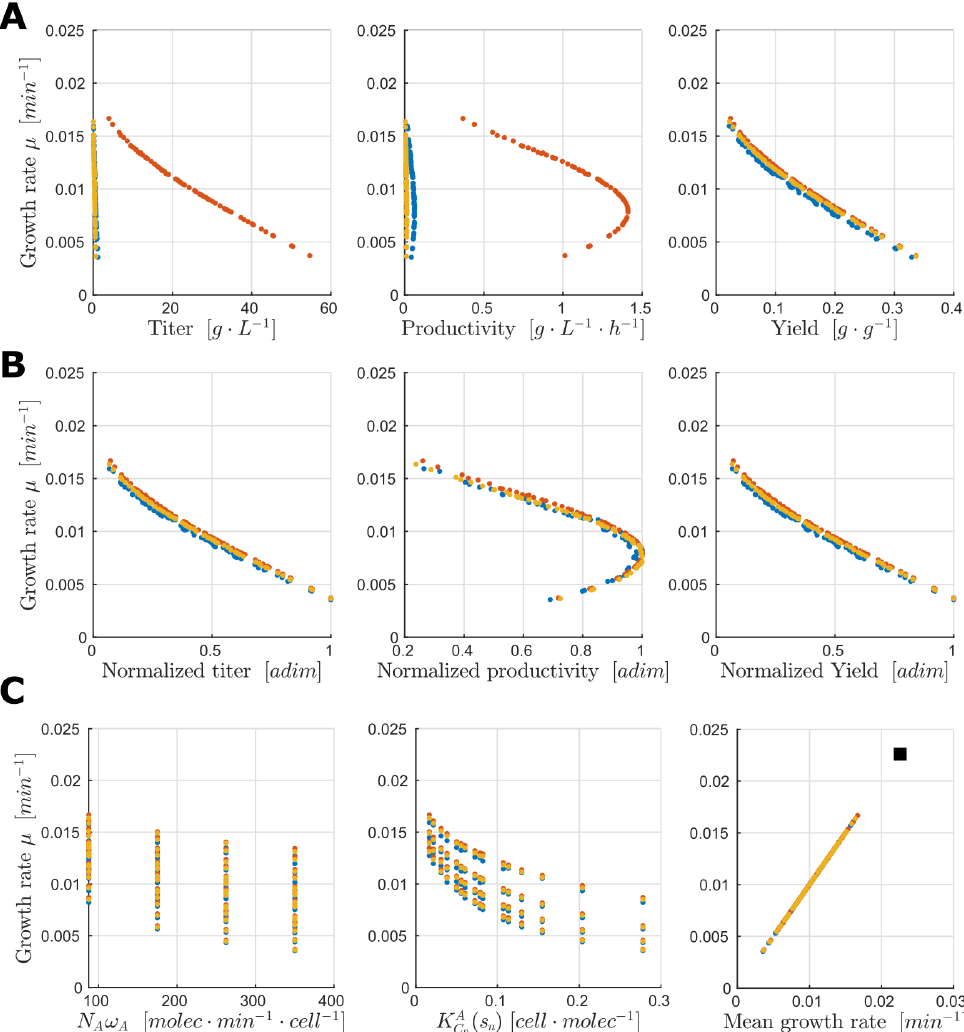
Figure 2. TRY of protein A across the gene expression space for batch, fedbatch and continuous operation obtained by simulation with the multi-scale model. All plots share the growth rate as ( s n ) the y-axis. Each dot corresponds to a different combination of transcription N A ω A and RBS K A C 0 strengths. The dot color corresponds to the following: blue, batch; red, fedbatch; yellow, continuous. ( A ) Absolute titer, productivity rate and yield. ( B ) Normalized titer, productivity rate and yield. ( s n ) used and their associated induced growth rate ( C ) Shows the combinations of N A ω A and K A C 0 ( s n ) at nominal substrate s n = 3.6g · L − 1 , since K A ( s ) is not constant because (note that we plot K A C 0 C 0 s changes in simulation time). The wild-type growth rate is shown with a black square